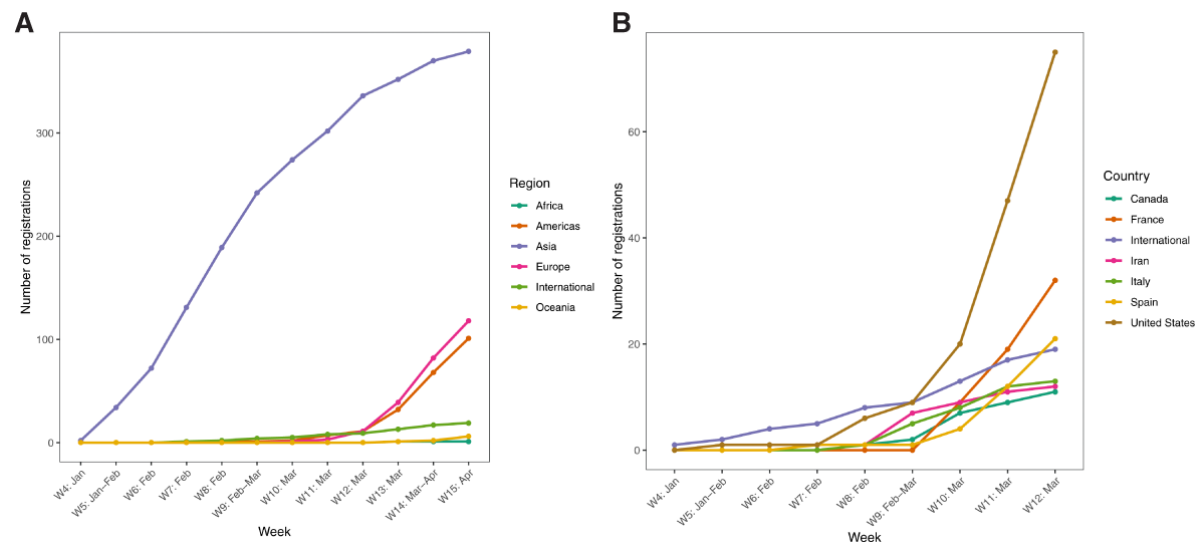
Figure 2. Cumulative number of registered trials over time ( a ) by continent, and ( b ) for countries with at least 10 registrations (excluding China). Four trials not shown were registered in 2019 or earlier, with a study design subsequently adapted to address COVID-19 (EUCTR2015- 002340-14-NL; NCT03680274; NCT03331445; and NCT03808922). For 18 trials the registration date was